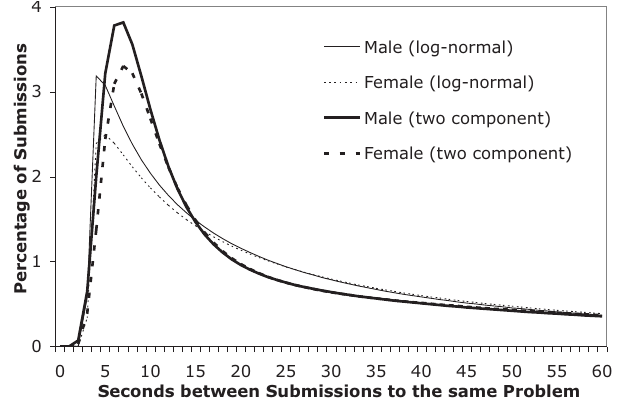
FIG. 7. Minimum- (cid:4) 2 -fit single and two component logarithmic- normal fits of the data (cid:1) Fig. 6 (cid:2) .